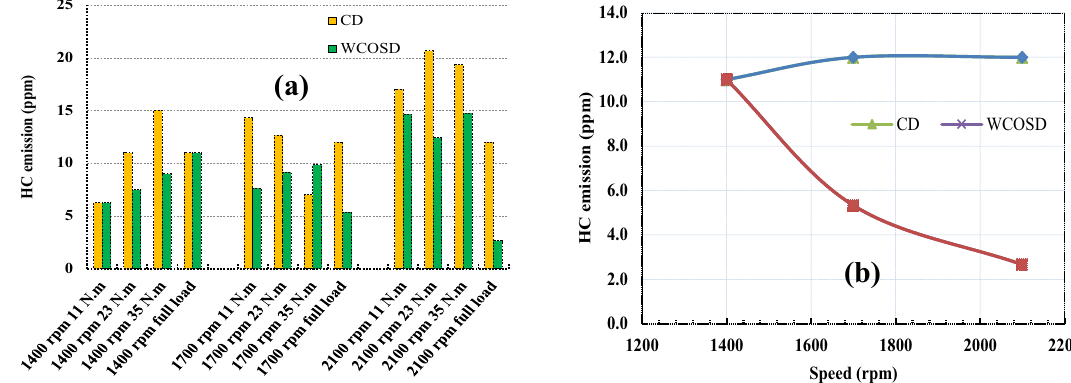
Fig. 9 Hydrocarbon emissions of the test engine fueled CD and WOCSD at a 1400 rpm, 1700 rpm, 2100 rpm and b full load